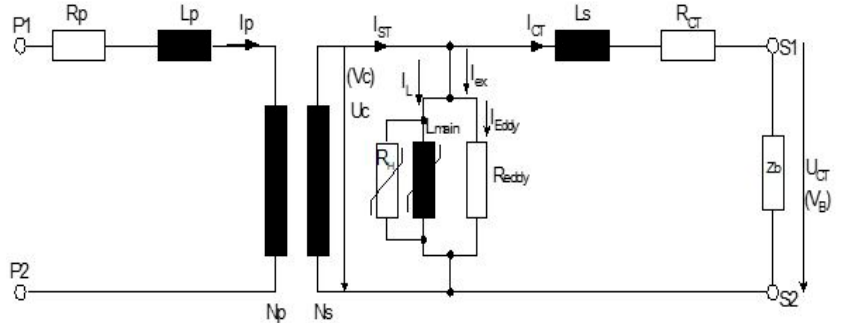
Figure 4. Equivalent circuit of the current transformer. Table 2. Results of factory test of current transformer.